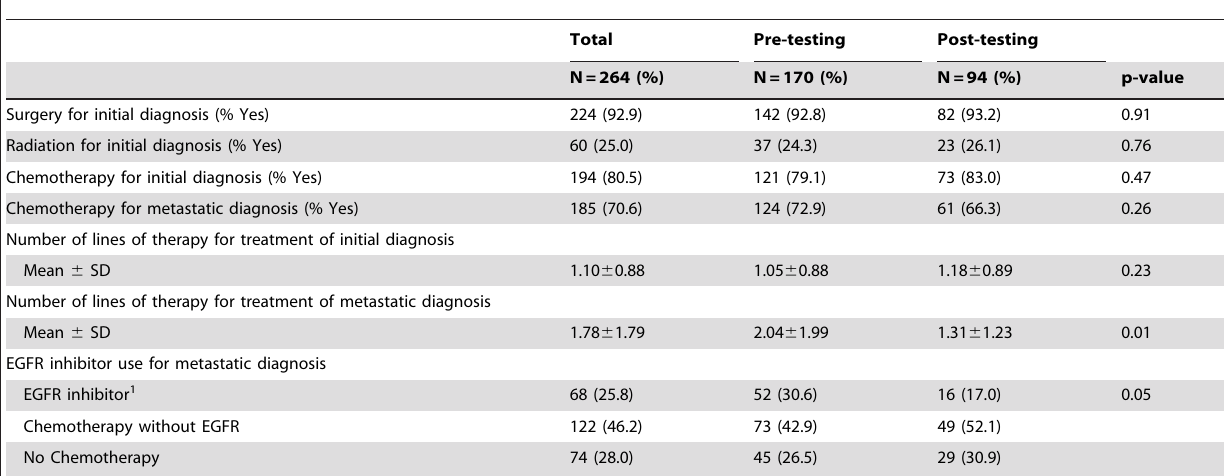
Table 2. Treatment patterns for 264 metastatic colorectal cancer patients diagnosed at Stage III by group.